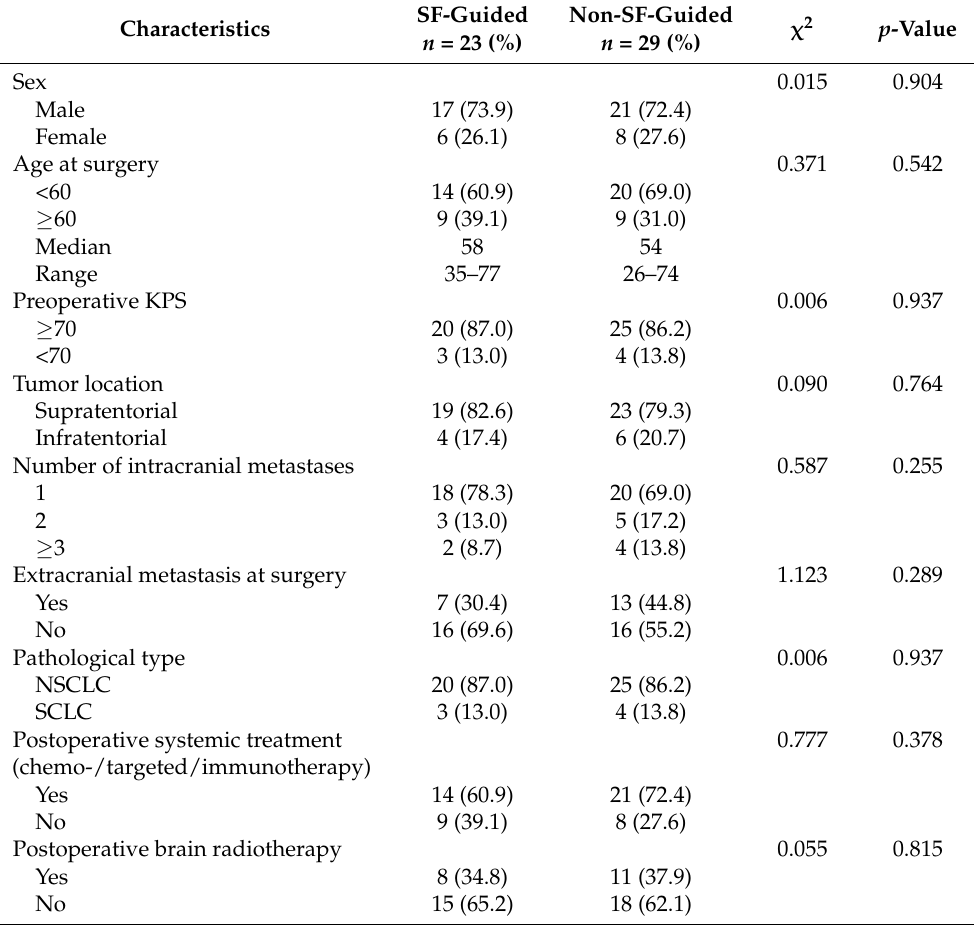
Table 1. Clinical baseline characteristics of patients with BMs from lung